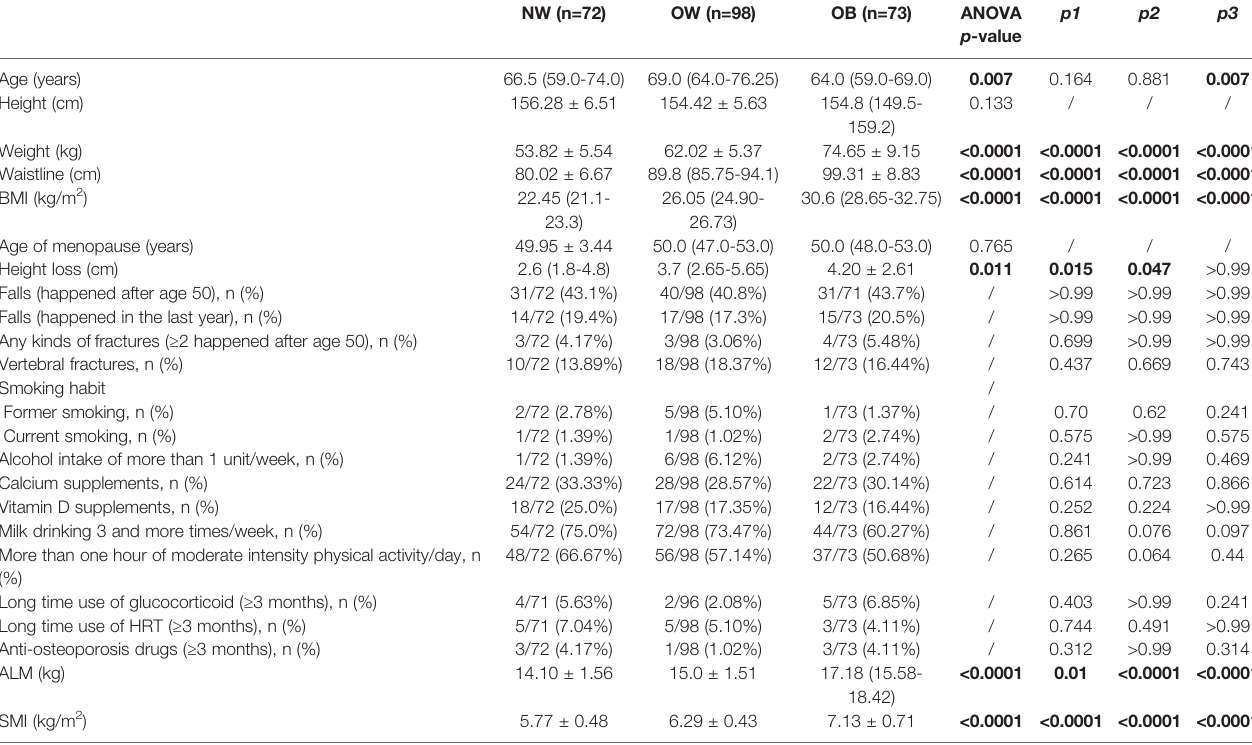
TABLE 1 | Clinical characteristics in normal-weight (NW), overweight (OW), and obese (OB) postmenopausal